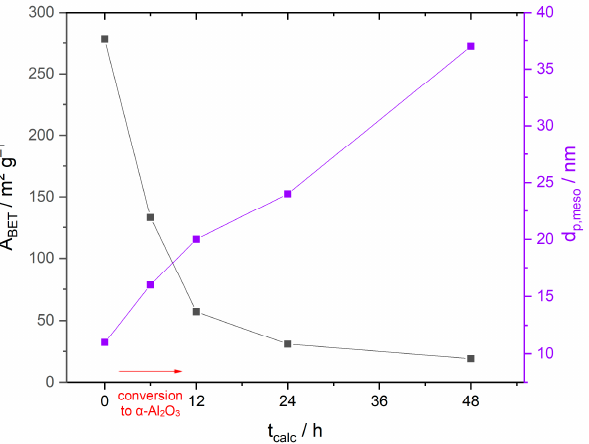
Figure 5. Specific surface areas A BET (grey) and mesopore diameter d p,meso (purple) of Mn- Figure 5. Speci fi c surface areas A BET (grey) and mesopore diameter d p,meso (purple) of Mn- impregnated samples calcined at 800 ◦ C, plotted as a function of the calcination duration. The impregnated samples calcined at 800 °C, plo tt ed as a function of the calcination duration. The sharp decrease of A BET within the fi rst few hours of the calcination is due to the transformation of γ -Al 2 O 3 sharp decrease of A BET within the first few hours of the calcination is due to the transformation of into α -Al 2 O 3 , as indicated by the red arrow. γ -Al α -Al 2 O 3 into 2 O 3 , as indicated by the red